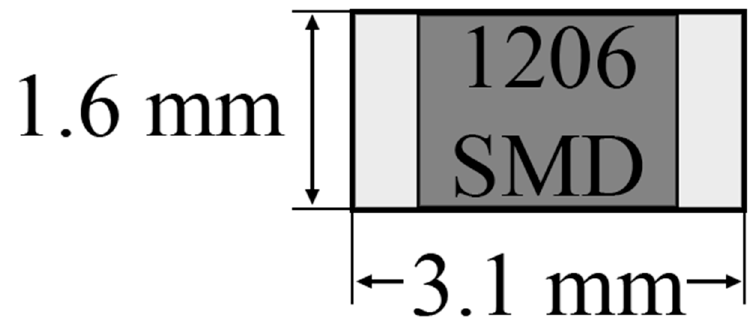
Figure 2. The schematic of SMD resistor with dimensions.